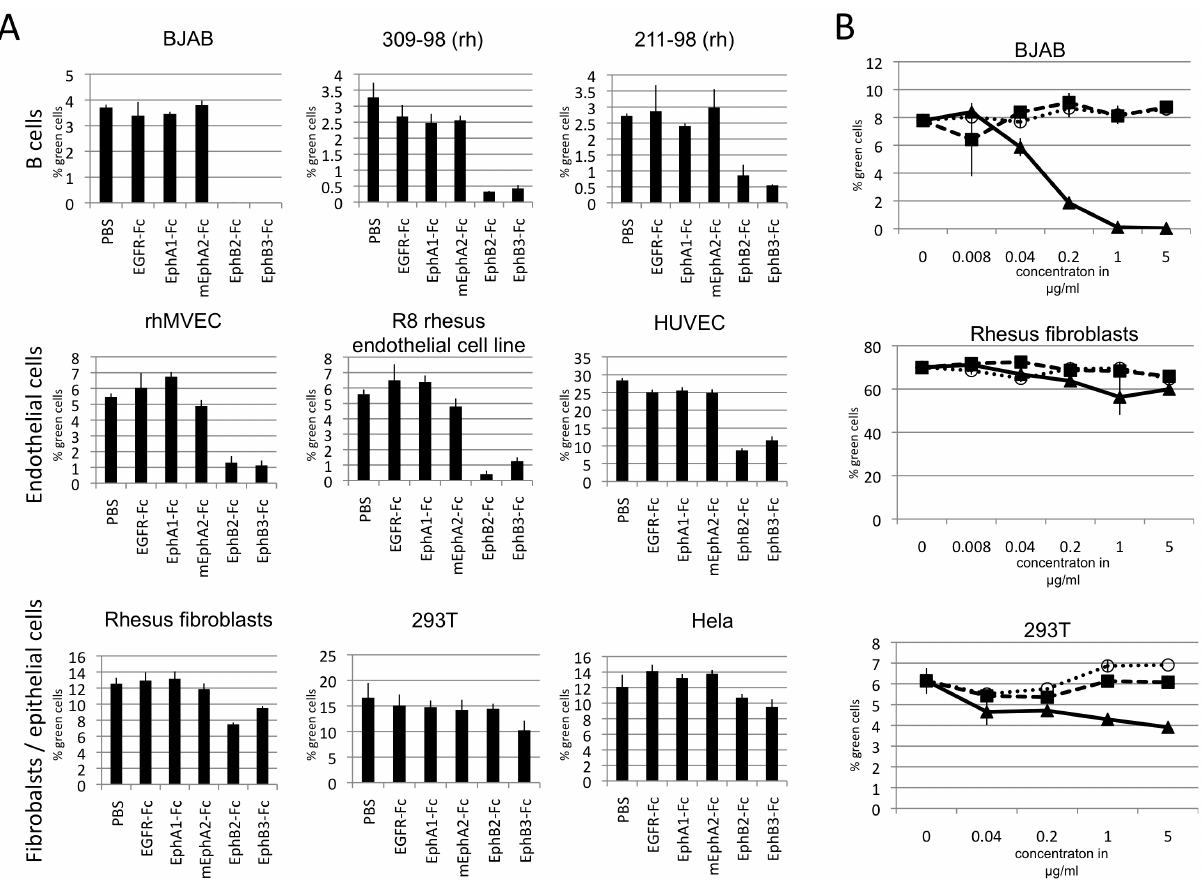
Figure 3. Inhibition of RRV entry by soluble Eph proteins. ( A ) Inhibition of RRV entry into cells of different lineages through block with soluble Eph proteins. RRV-GFP 26-95 was pre-incubated with EphA1-Fc, mEphA2-Fc, EphB2-Fc, EphB3-Fc or EGFR-Fc as a control prior to infection. All proteins were used at 1 m g/ml. (n=4 for rhMVEC, R8 and HUVEC, else n=3; error bars indicate sd) ( B ) Dose dependent inhibition of RRV entry by soluble Eph proteins. BJAB, rhesus fibroblasts and 293T cells were infected with RRV-GFP 26-95 that was pre-incubated at the indicated concentrations prior to infection with either murine EphA2-Fc (black boxes), EphB3-Fc (black triangles) or EGFR-Fc (open circles) as control. Viral entry as indicated by GFP expression was quantified by flow cytometry. (n=3 per data point for 293T and BJAB, n=2 for rhesus fibroblasts; error bars indicate sd for n=3 or range for n=2).